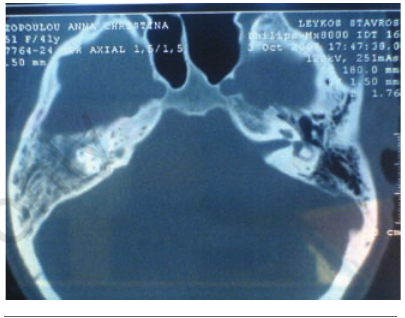
Figure 10. Right mastoiditis (CT scan-axial projection). The patient underwent corti- cal